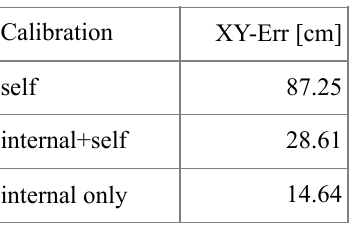
Table 4: RMS error estimates for all GCP's of test site "WSL